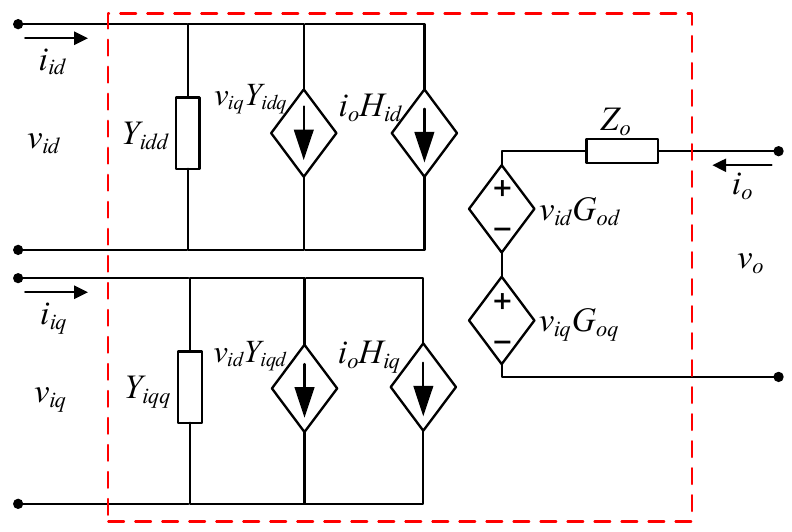
Figure 3. The g-parameters-based model for three-phase ac–dc PEC.